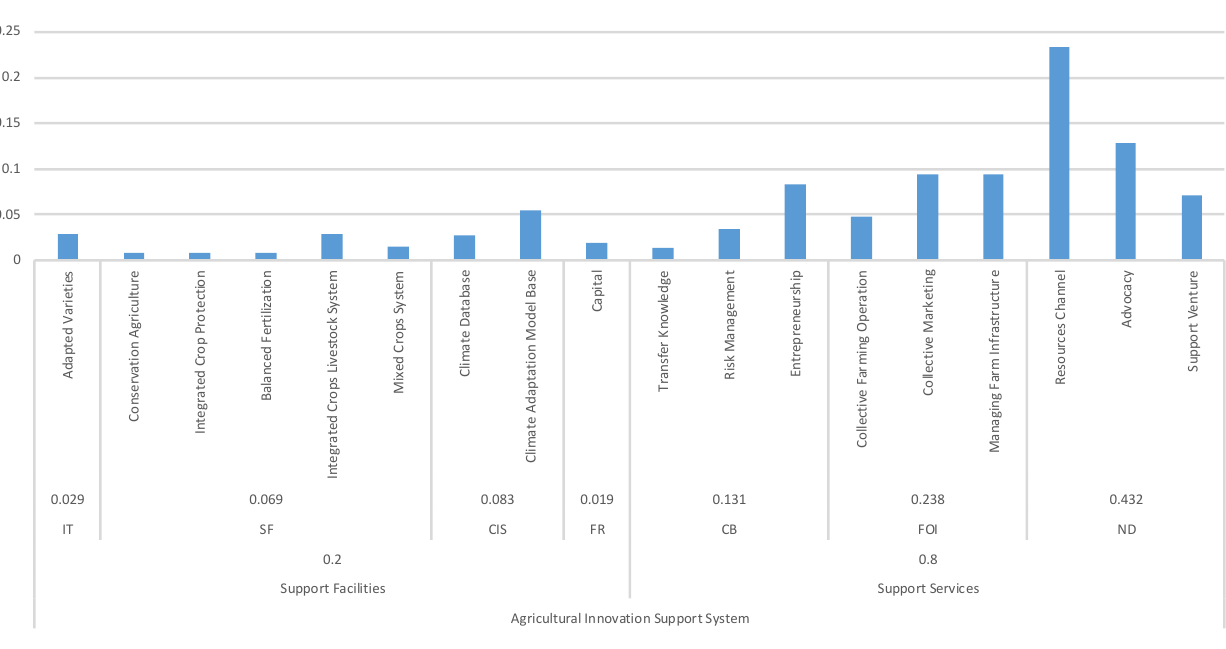
Figure 6. Priority number of agricultural innovation support system for Arabica farmers.